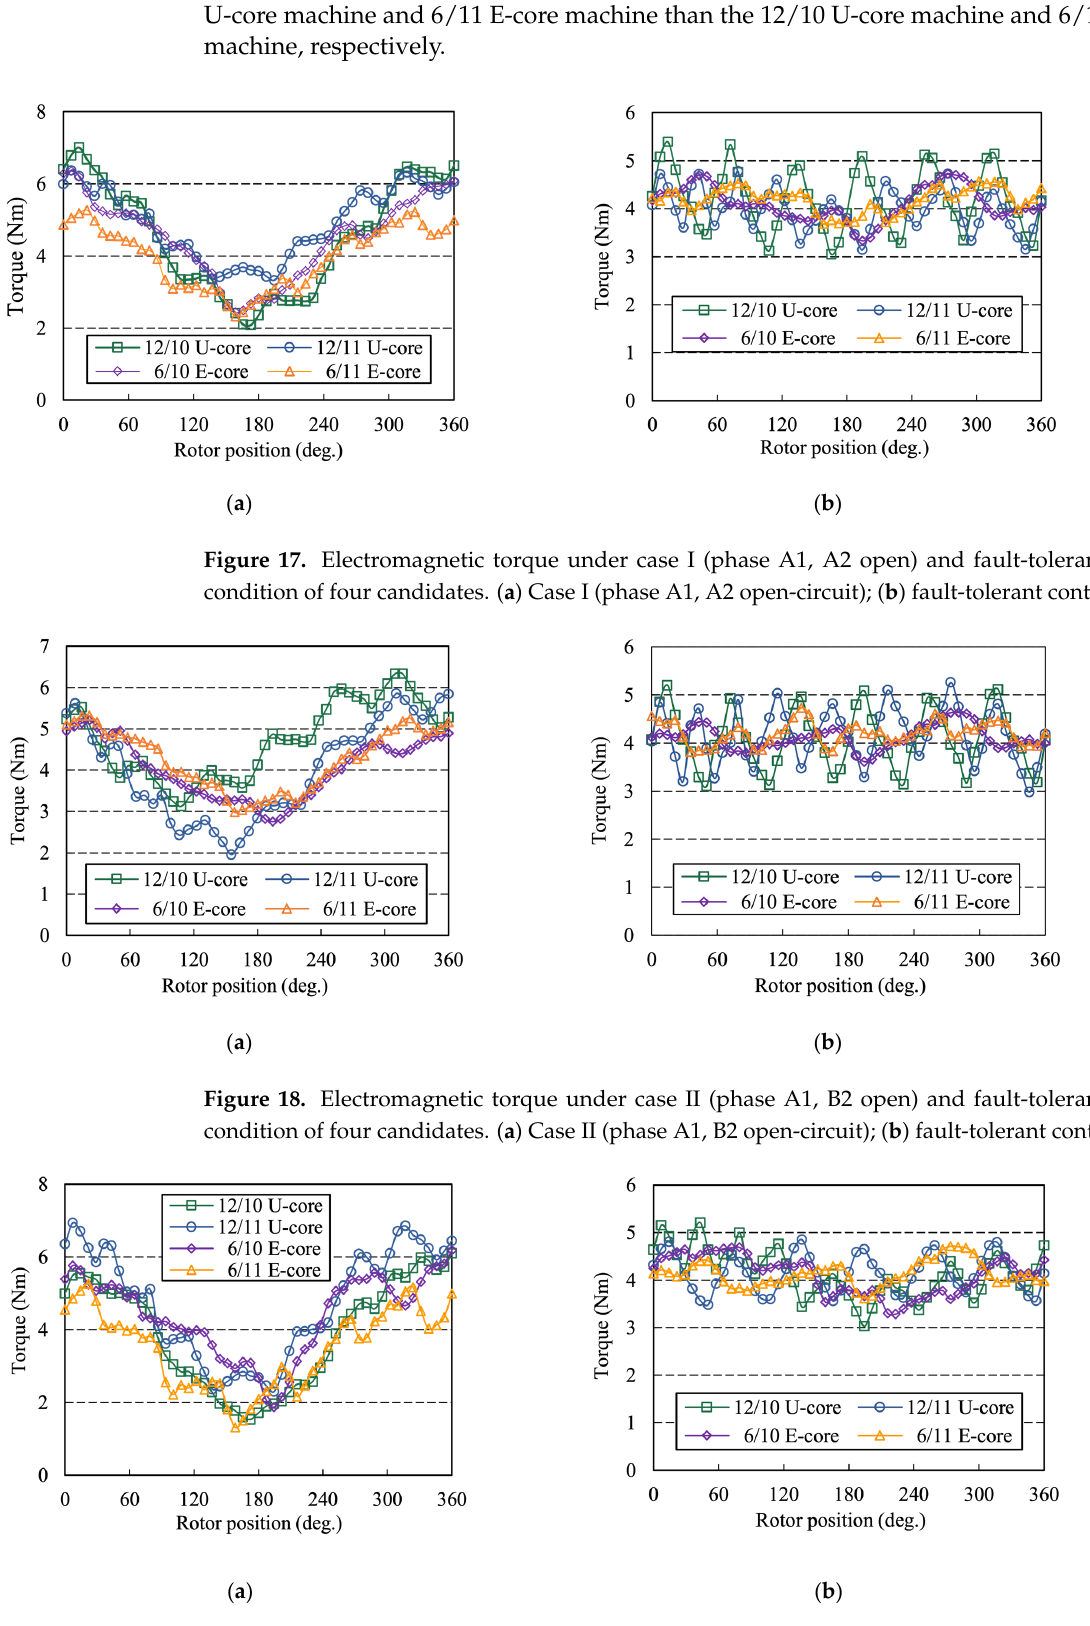
Figure 19. Electromagnetic torque under case III (phase A1, B1 open) and fault-tolerant control condition of four candidates. ( a ) Case III (phase A1, B1 open-circuit); ( b ) fault-tolerant